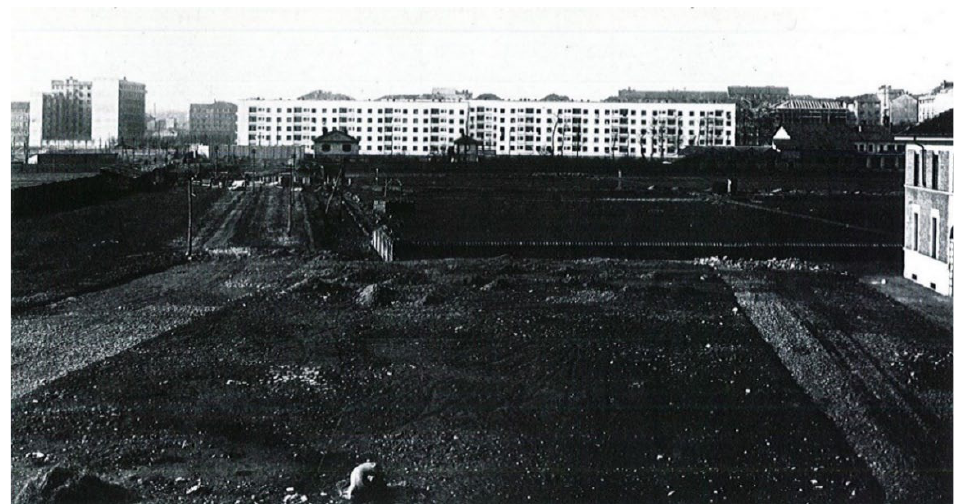
Figure 8 Quartiere Fabio Filzi. Photograph by Giuseppe Colonese. 1940. (Archivio CFP Bauer,